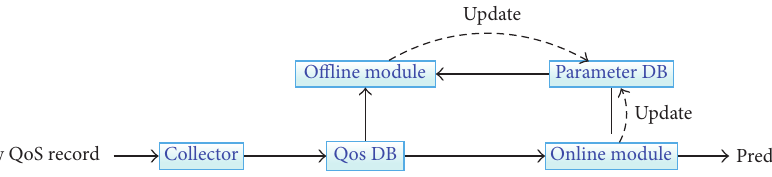
Figure 1: QoS prediction system